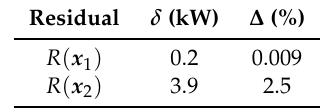
Table 4. Average absolute and percentage residuals between measurement and model estimation.